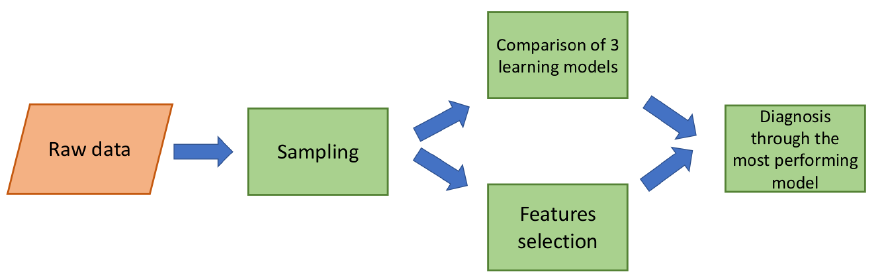
Figure 1. Flowchart of the proposed methodology. After sampling we selected the most performing learning algorithm and implemented a feature reduction procedure. Finally we used the selected learning model to classify the patients in the three CVD risk